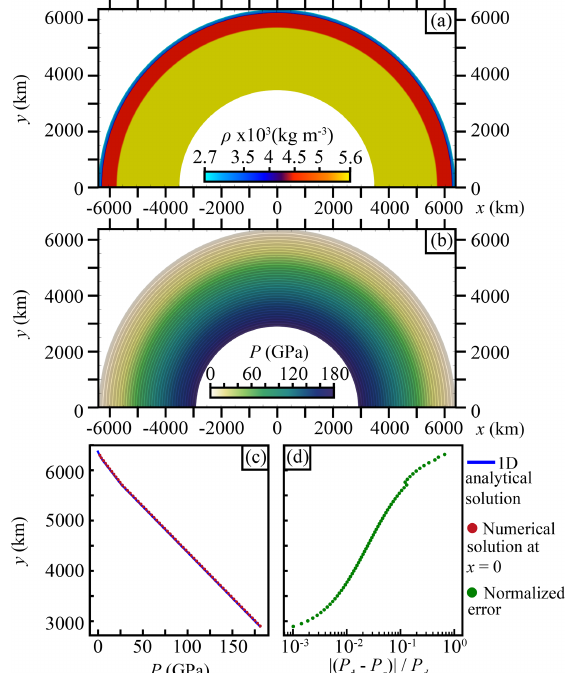
Figure 2. Pressure for non-dimensioned hydrostatic cases. Panels (a, c, e) show the 1D pressure for (a) a constant density ρ = 1, (c) a continuous y -dependent density ρ = 2 − y , and (e) a discontin- uous density. The blue line is the analytical solution computed with Eq. (2), and the red circles represent the numerical solution com- puted with Eq. (7). Panels (b, d, f) show the 2D numerical solution for (b) a constant density ρ = 1, (d) a continuous y -dependent den- sity ρ = 2 − y , and (f) a discontinuous density.